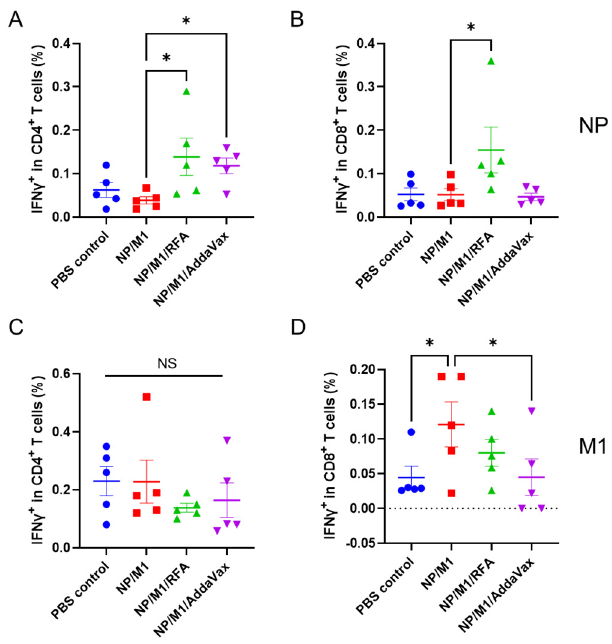
Figure 2. RFA enhances NP-specific cellular immune responses. C57BL/6 mice were subjected to RF or sham treatment followed by ID injection of 5 µ g NP and 5 µ g M1 into RF (NP/M1/RFA) or sham-treated skin (NP/M1), or IM injection of 5 µ g NP and 5 µ g M1 in the presence of AddaVax (NP/M1/AddaVax), or ID injection of PBS (PBS control). Immunizations were repeated 3 weeks later. PBMCs were collected one week after boost, stimulated with NP or M1 followed by intracellular cytokine staining and flow cytometry analysis. Cells were first gated based on FSC and SSC and then based on CD4 and CD8. Percentage of IFN γ -secreting cells in CD4 + and CD8 + T cells stimulated by NP are shown in ( A , B ) and stimulated by M1 are shown in ( C , D ), respectively. n = 5. One-way ANOVA with Fisher’s LSD test was used to compare difference between NP/M1 and other groups. *, p < 0.05; **, p < 0.01; ***, p < 0.001; NS, not significant.